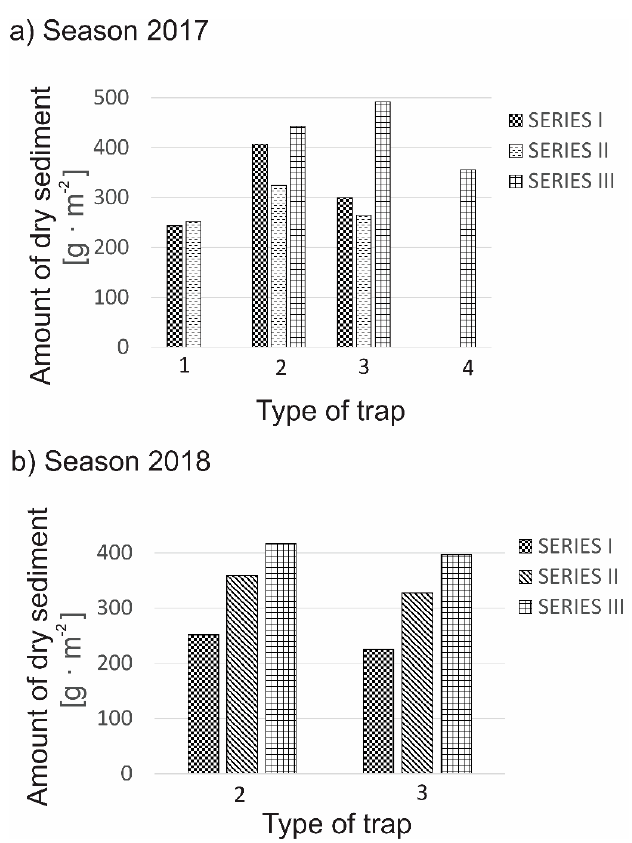
Figure 4. Effectiveness sediment accumulation in traps systems expressed in terms of the masses of sediment collected (in g ∙ m − 2 ) - a) refers to season 2017, b) refers to season 2018.